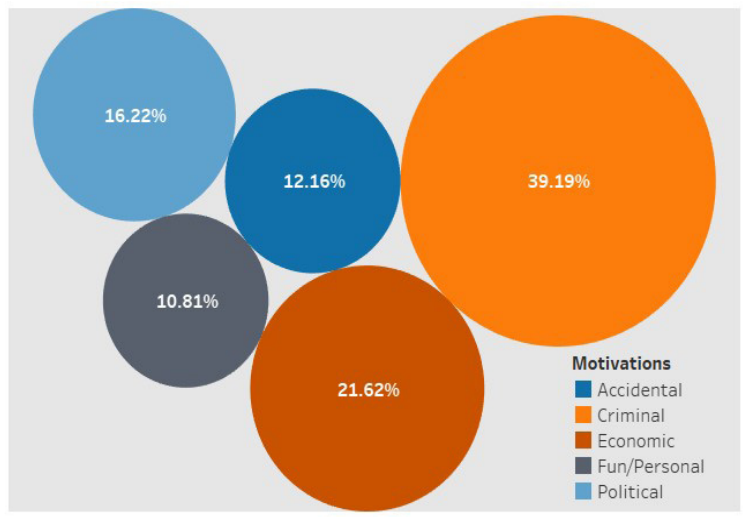
Figure 9: Motives behind cyber incidents, 2010–2020